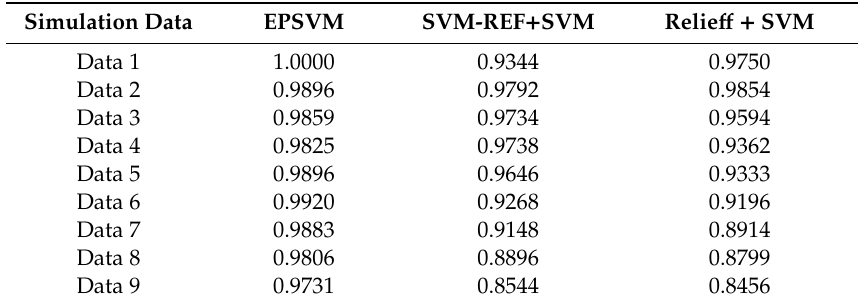
Table 4. NER of simulation data.